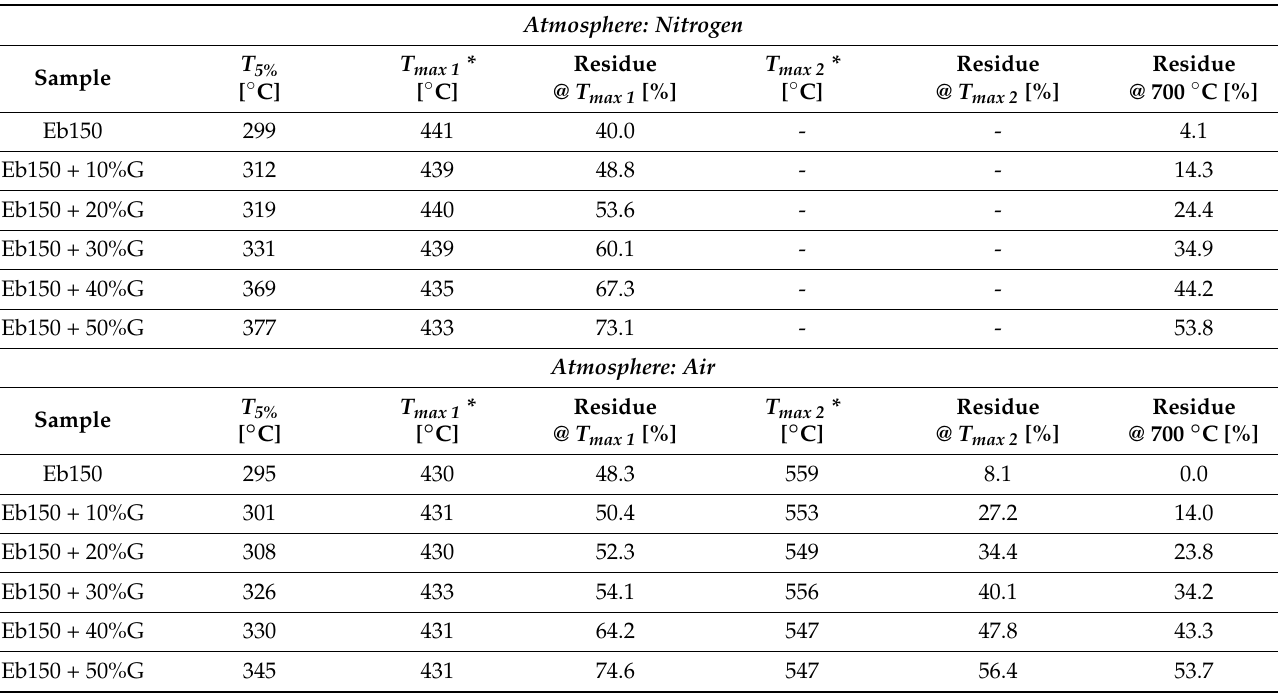
Table 2. Thermal and thermo-oxidative stability of UV-LED cured